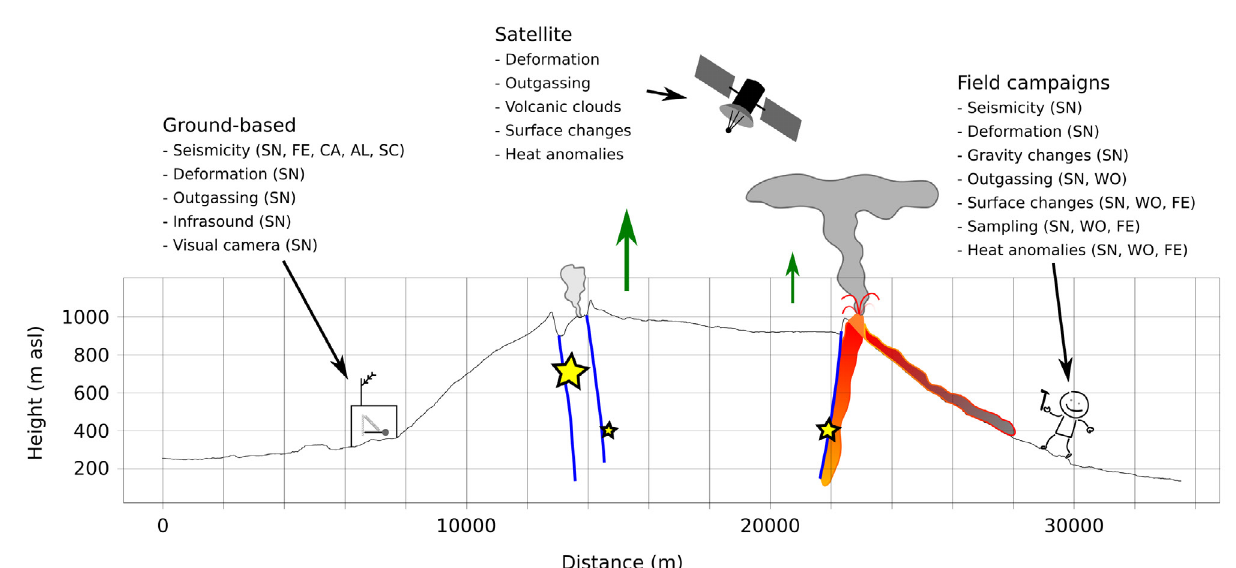
Figure 2: Idealized diagram of the IG-EPN multi-parametric monitoring system at Galápagos volcanoes. SN: Sierra Negra; FE: Fernandina; CA: Cerro Azul; AL: Alcedo; SC: Santa Cruz; WO: Wolf. Stars are representative earthquake hypocenters; blue lines are caldera bounding faults; green arrows show typical pre-eruptive ground